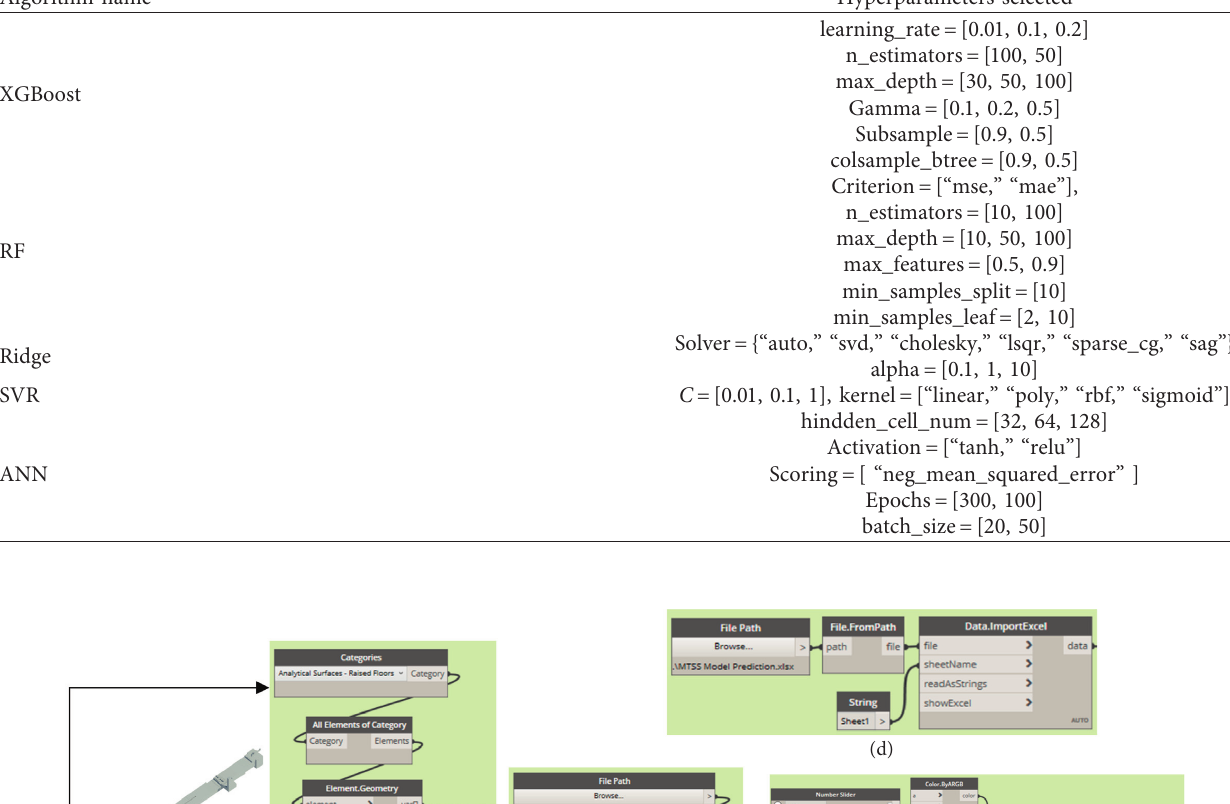
Table 1: Hyperparameter range of each algorithm.